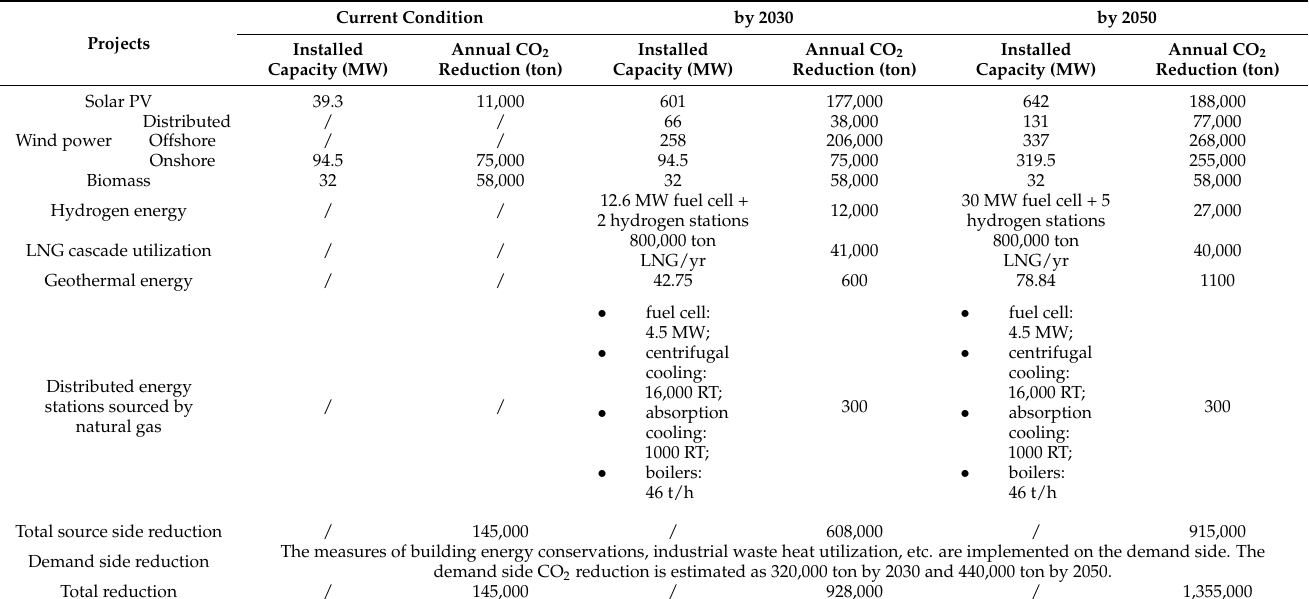
Table 18. The CO 2 emission reductions of the source and demand side.